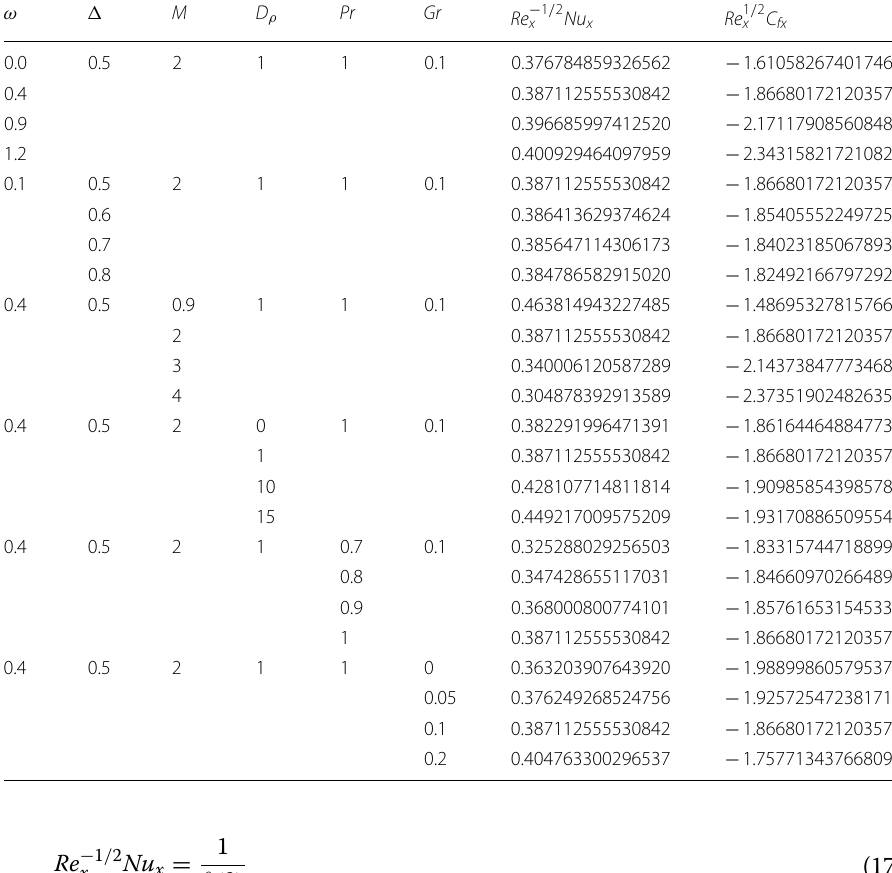
Table 2 Values of Nusselt number Re − 1 / 2 x Nu x and skin friction Re 1 / 2 x C fx for several values of ω , (cid:31) , M , D ρ , Pr , and Gr for Ŵ =